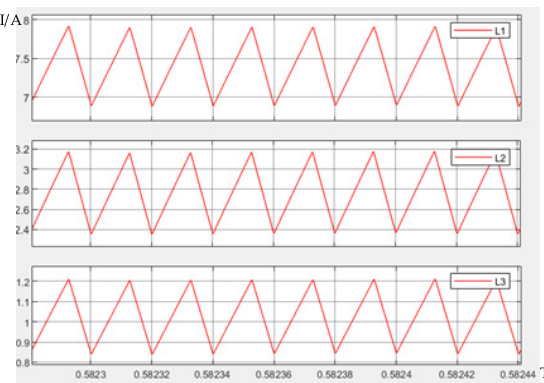
Figure 9. Current through high gain converter inductors.